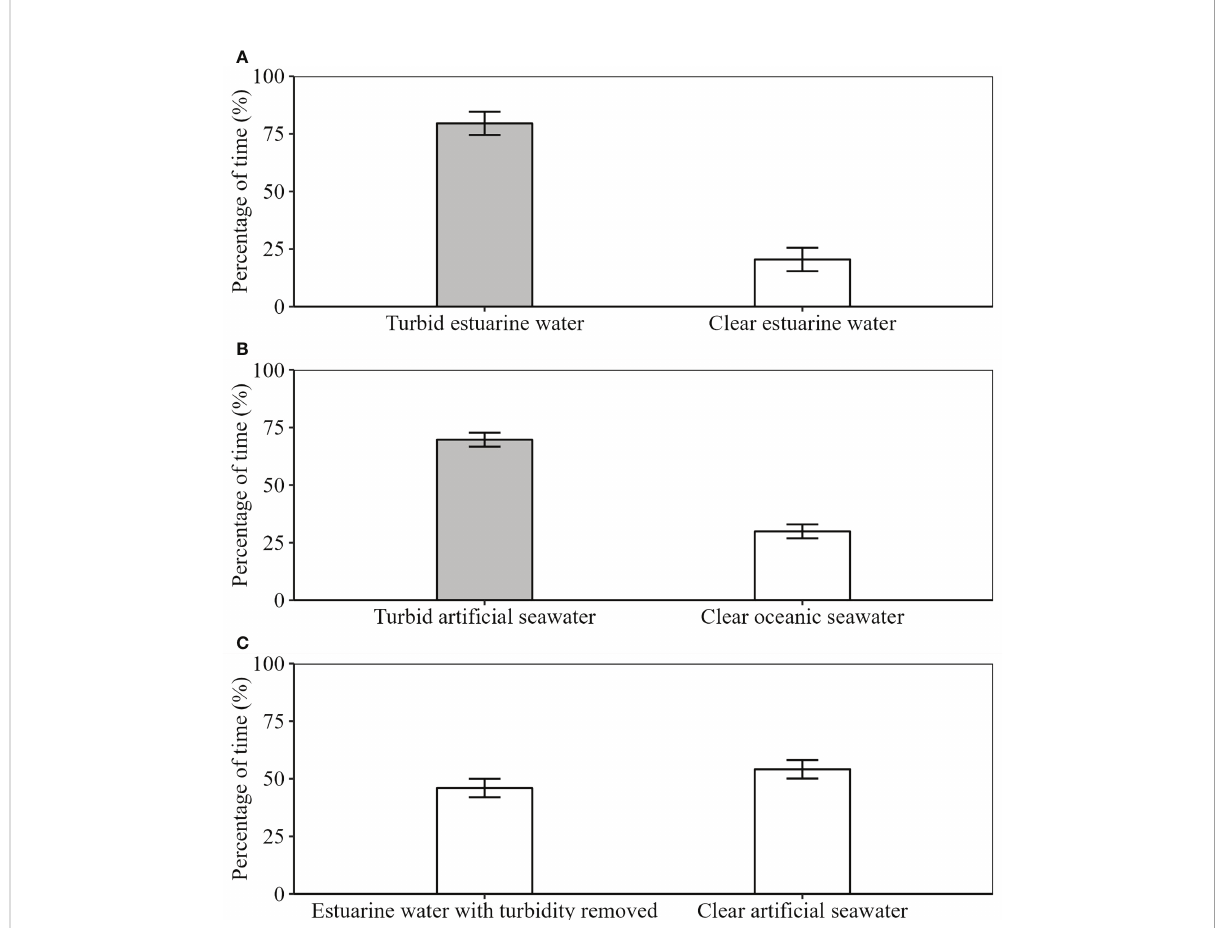
FIGURE 3 Mean percent preference ( ± SE) of settlement-stage Argyrosomus japonicus (n = 54) when given the choice of (A) turbid estuarine water (sourced from the Great Fish Estuary) or clear estuarine water (sourced from the Kariega Estuary), (B) clear seawater or turbid arti fi cial seawater and (C) estuarine water with turbidity removed (sourced from the Great Fish Estuary) or clear arti fi cial seawater. Grey bars indicate the turbid water and white bars indicate clear